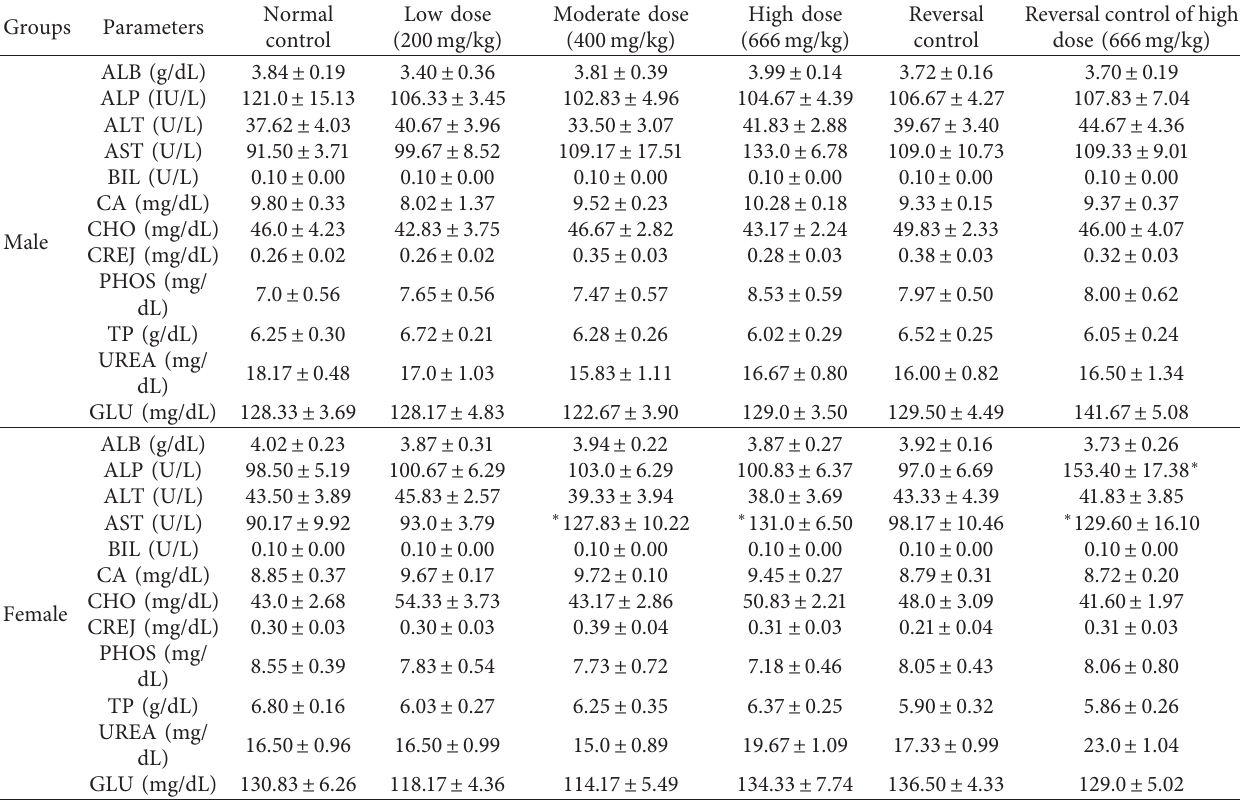
Table 2: Evaluation of biochemical parameters in the repeated oral dose subacute toxicity study of AND-2-HyP- β -CYD complex.